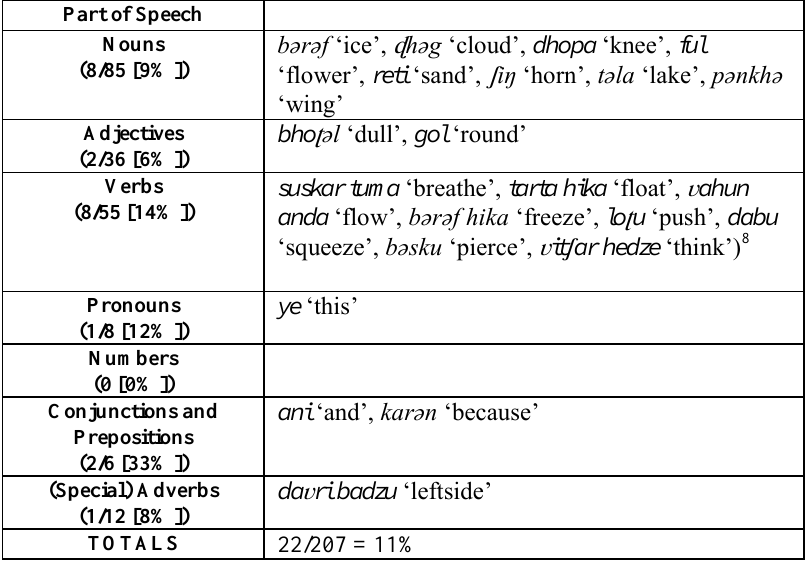
Table VII. Lexical replacements to the core vocabulary in